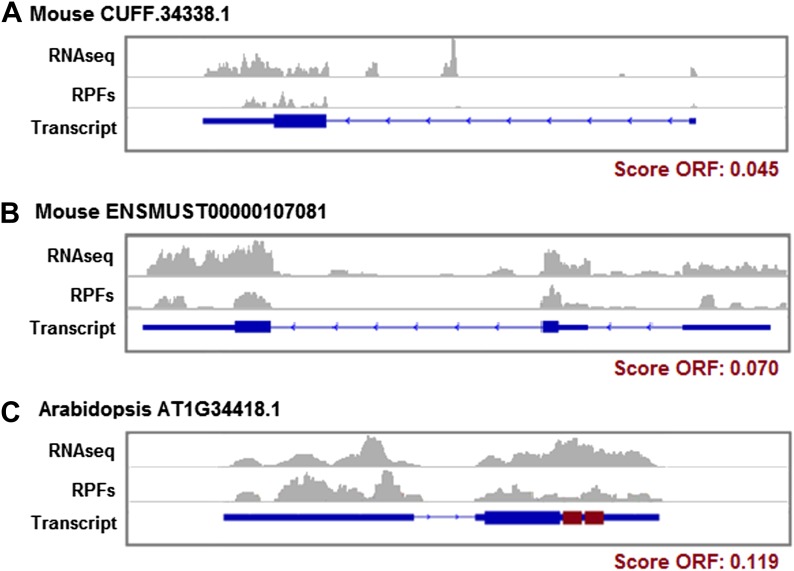
Ribosome protection patterns in transcripts containing short ORFs.(A) Mouse CUFF.34338.1 (chr5:113183493–113188347) is a novel lncRNA, it contains an ORF encoding a 169 amino acid protein associated with ribosomes and with protein-coding homologues in human, zebrafish, and yeast. (B) ENSMUST00000107081 is an annotated codRNA in mouse which evolved recently since no homologues were found in any other species. It has a small ORF that translates a 55 amino acid protein. (C) AT1G34418.1 is an annotated lncRNA in Arabidopsis showing abundant association with ribosomes in the 5′UTR region, the primary ORF (34 amino acid) and the final region of the transcript, which contains two redundant ORFs (in red) coding the sequence: MGLGFVN(V/F)LLGM. RNAseq: profile of RNAseq reads. RPFs: profile of ribosome profiling reads. Exon-intron transcript structures are represented; the thickest boxes on the exons are the primary ORFs.